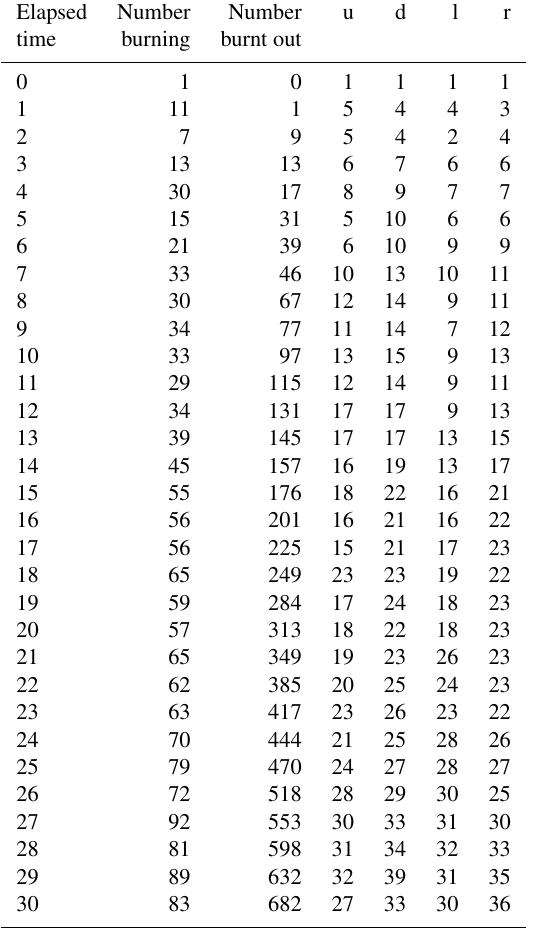
Table 1. Counts of the six statistics for the third microfire at a se- quence of times (measured in seconds): numbers of burning sites, burnt-out points, and the four nearest-neighbour counts.